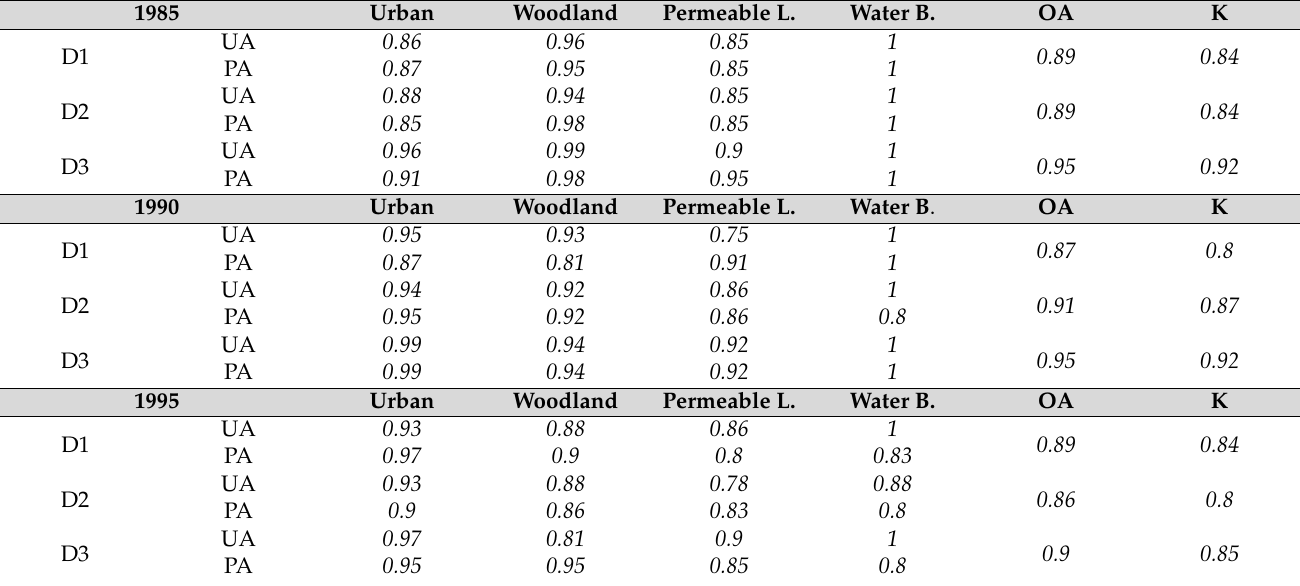
Table 3. Accuracy metrics of the different datasets derived from Landsat-5.